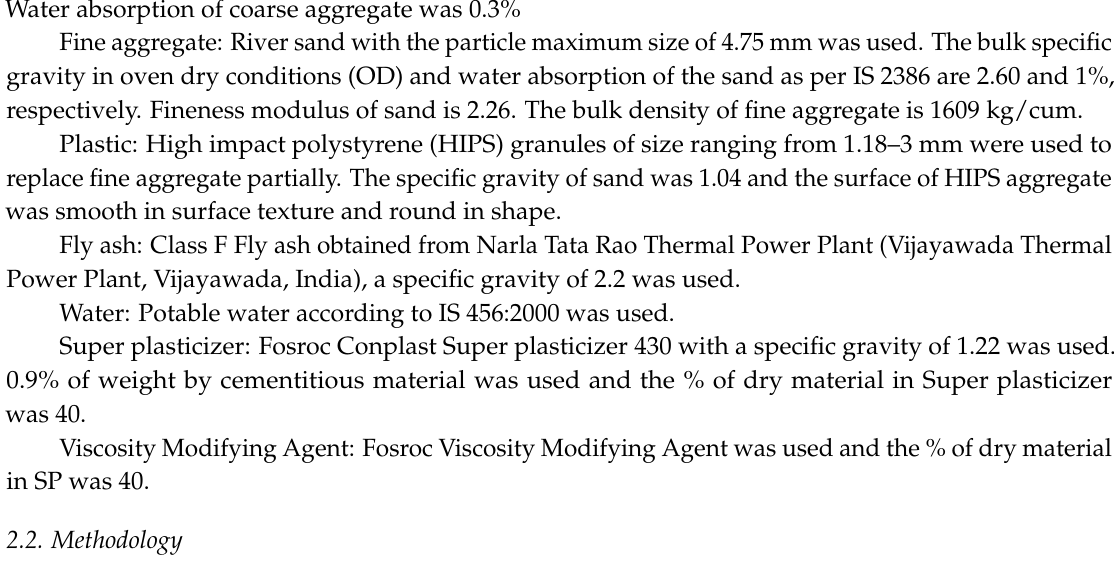
Associations Representing for Concrete 2005